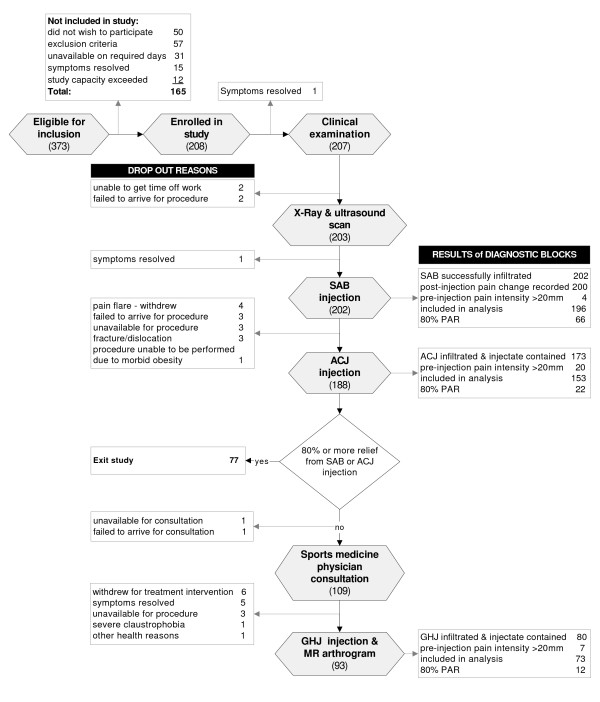
Diagram showing study procedures, results of diagnostic blocks and dropout explanations. SAB, subacromial bursa; PAR, positive anaesthetic response (≥80% post-injection reduction in pain intensity); ACJ, acromioclavicular joint; GHJ, glenohumeral joint; MR arthrogram, magnetic resonance arthrogram. Numbers refer to the number (n) of subjects.